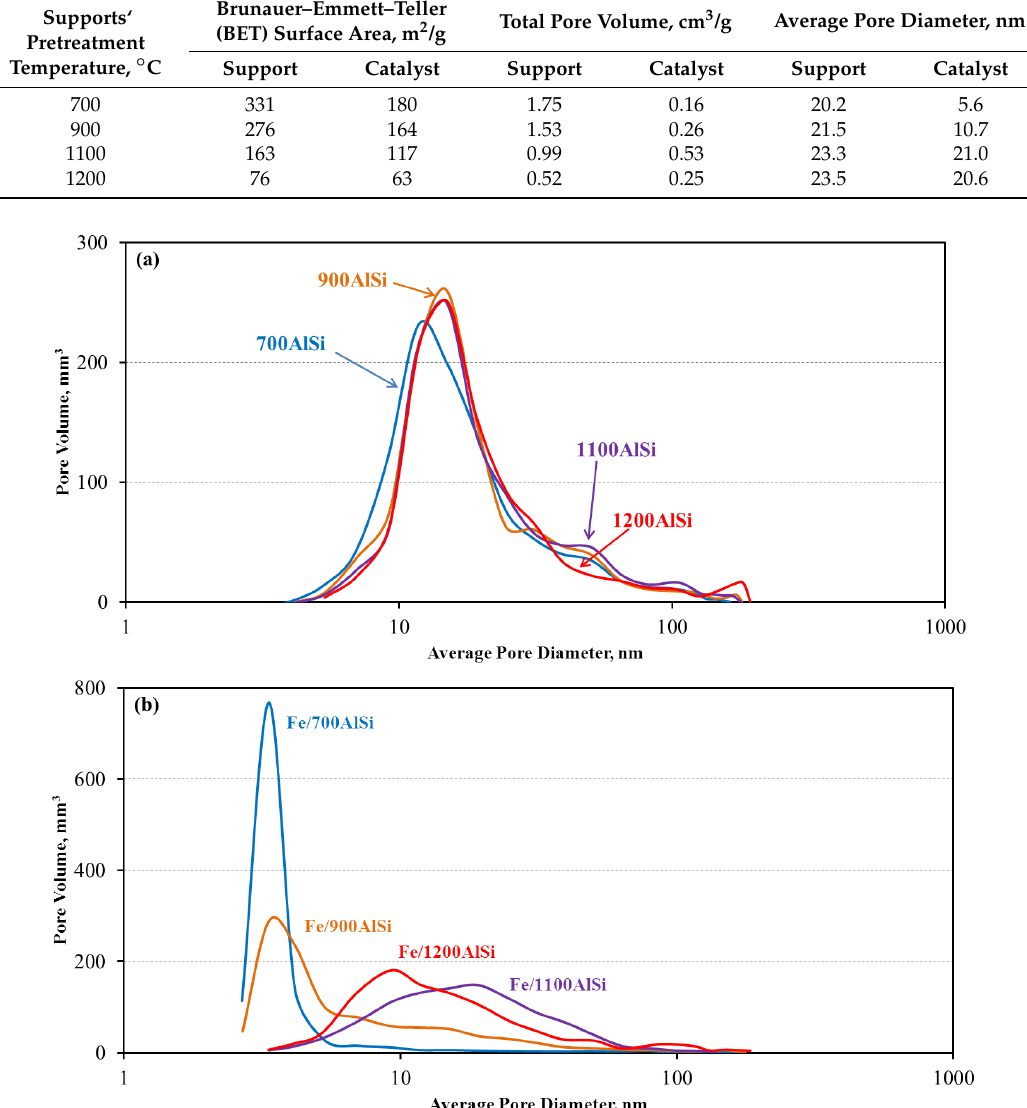
Figure 1. Brunauer–Emmett–Teller (BET) results of ( a ) supports calcined at different temperatures and ( b ) catalysts with supports calcined at different temperatures.